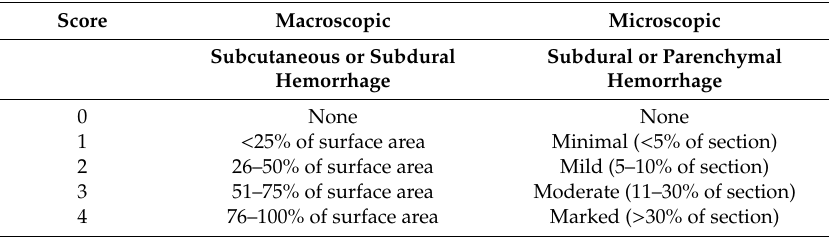
Gross and microscopic pathology scoring criteria for macroscopic, and microscopic hemorrhage